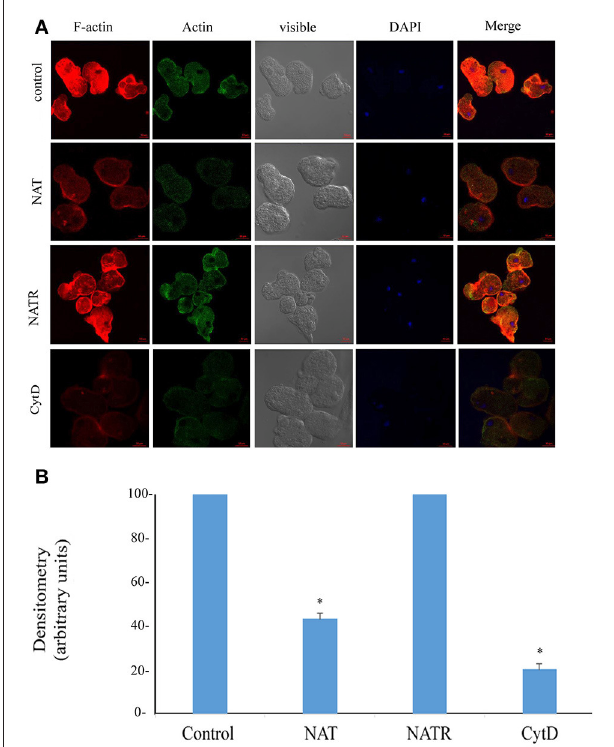
FIGURE 3 | (A) Confocal laser scanning microscopy of F-actin and total actin in control E. histolytica trophozoites, NAT, NATR, and CytD-treated E. histolytica trophozoites. F-actin was detected using rhodamine-conjugated phalloidin. Total actin was detected using a primary actin antibody and a secondary Cy2-conjugated IgG antibody. The nuclei (blue) were stained by DAPI. Computer-assisted image overlay of the signal emitted by the actin antibody, phalloidin, and DAPI. (B) Analysis of the F-actin signal (fluorescence) in control trophozoites, NAT, NATR and CytD-treated trophozoites. The analysis has been performed with the Fiji software on 20 trophozoites. The signal from control trophozoites was set at 100 and data are displayed as the mean ± standard deviation. * p <